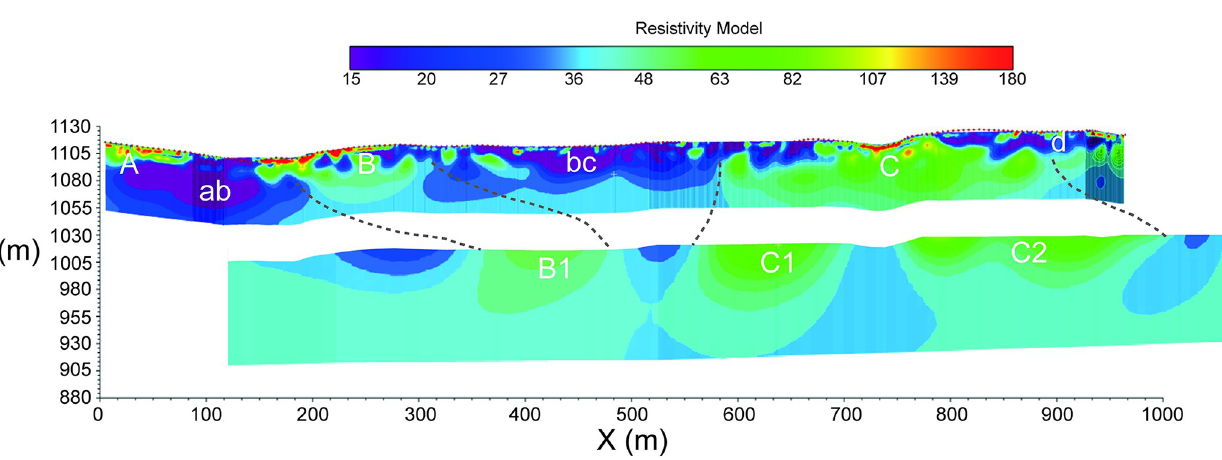
Fig 5. Mosaic of SPS (upper) and MSS (lower) ERT